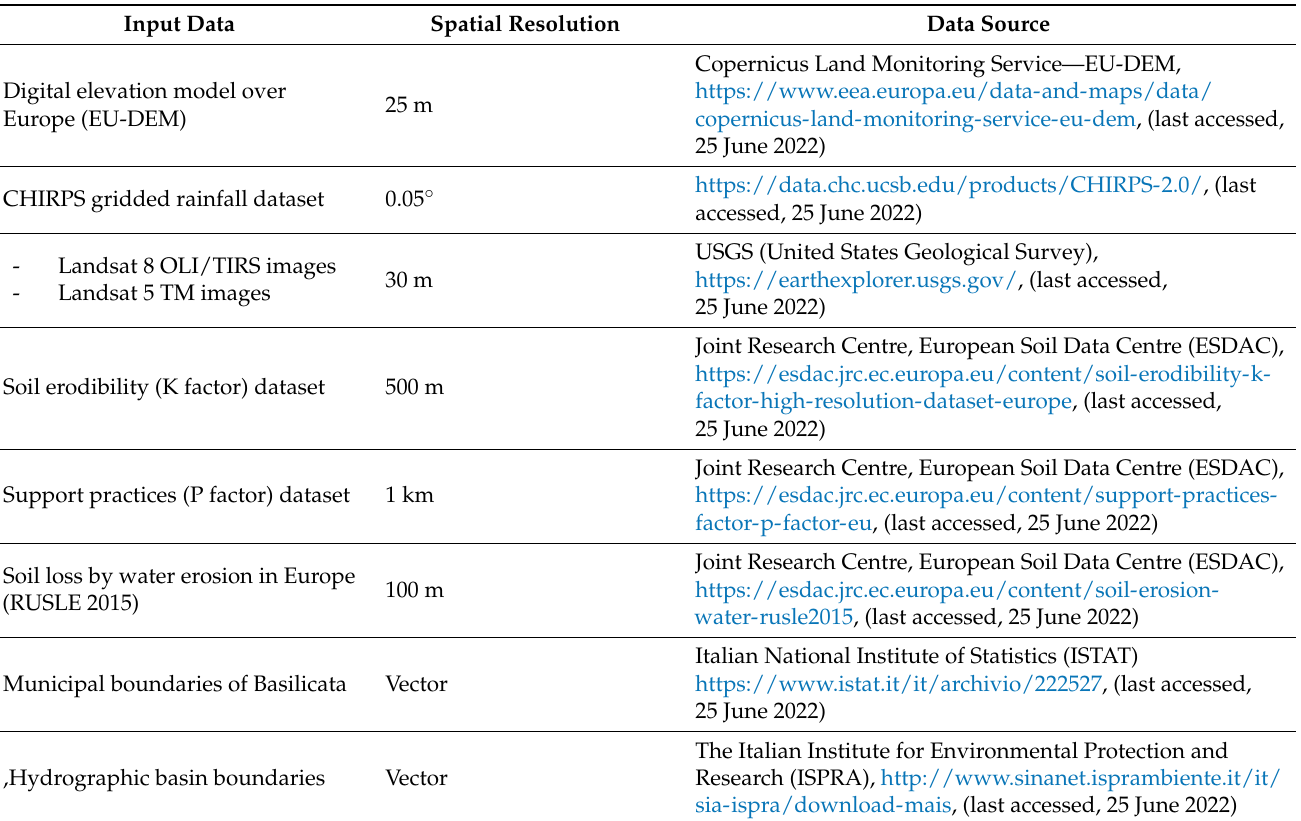
Table 3. Summary of the input data for the RUSLE